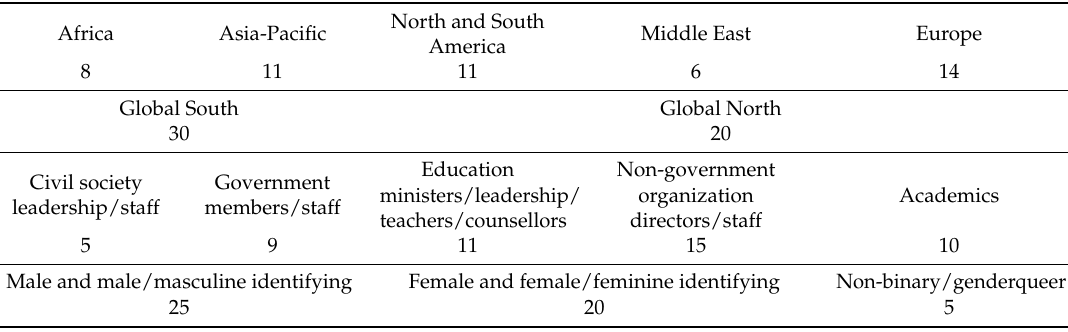
Table 1. General traits of Key